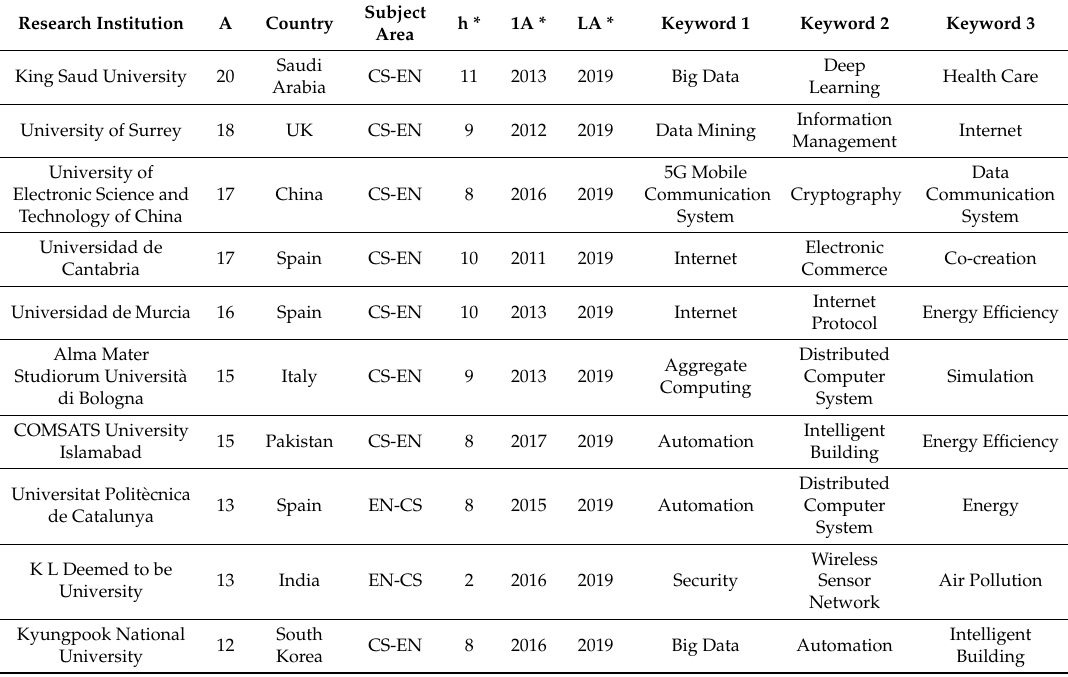
Table 13. Top 10 research institutions and main keywords